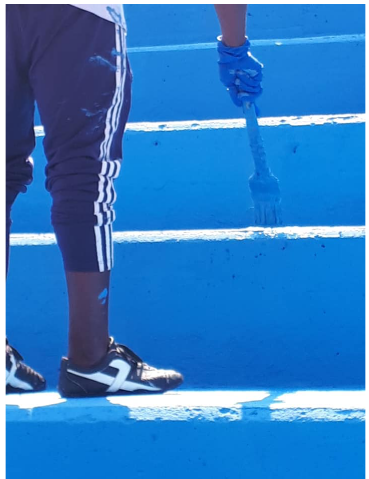
Figure 3: A beautiful image from Moussa’s gallery, showing him painting the stadium’s steps in